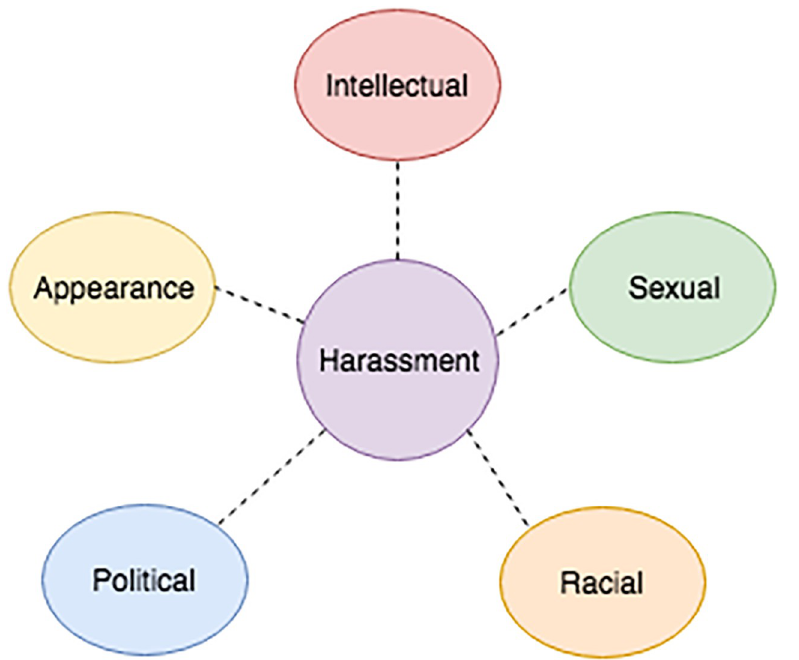
Fig 1. Five contextual types of